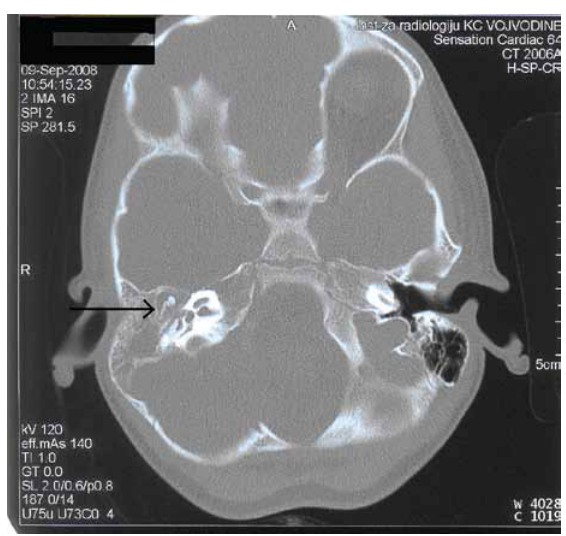
Figure 1. Temporal bone computed tomography (CT) scan of a